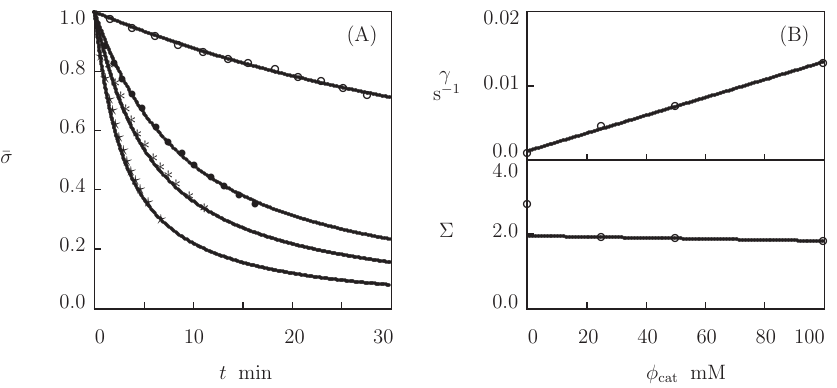
Figure 4. ( A )–Normalized stress ¯ σ = σ ( t ) / σ ( 0 ) versus relaxation time t . Symbols: experimental data [69] on HA gels that were cross-linked by hydrazine-aldehyde complexation with mass fraction of HA φ = 0.02 and various concentrations of catalyst φ cat ( (cid:63) – φ cat = 100 mM). Solid lines: the results of simulation. ( B )–Parameters γ and Σ versus concentration of catalyst φ cat . Circles: treatment of observations. Solid lines: the results of